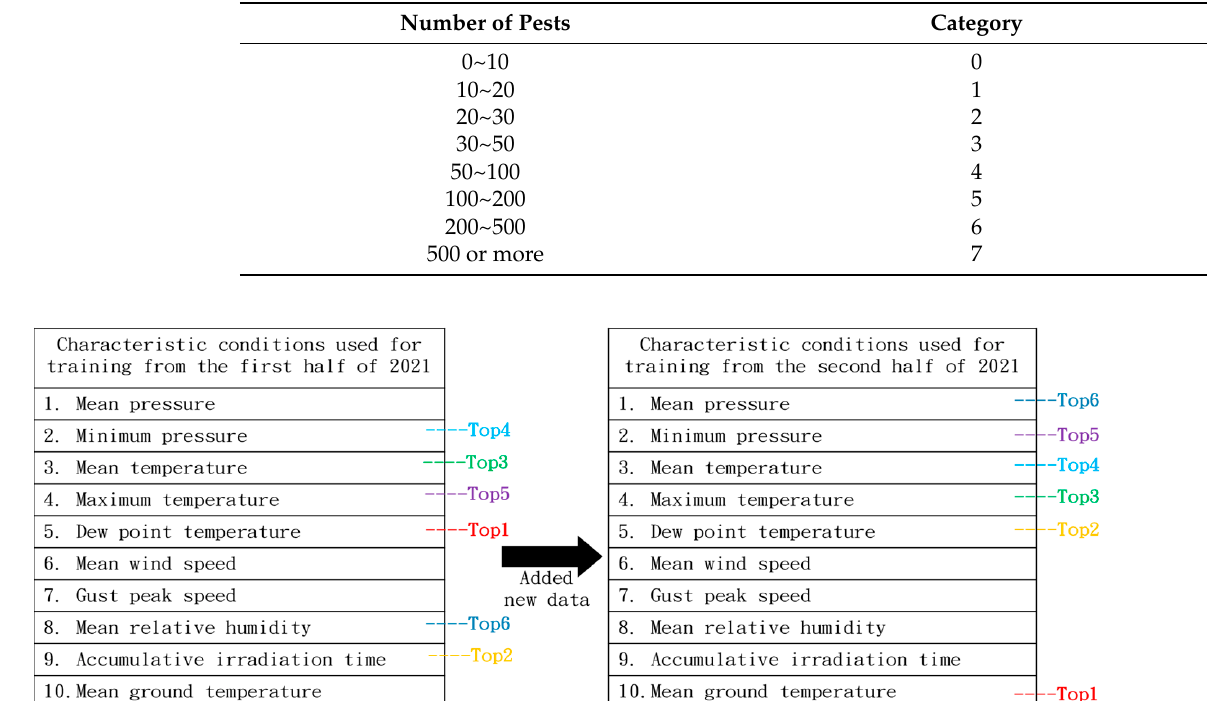
Table 2. Classification of the numbers of pests.